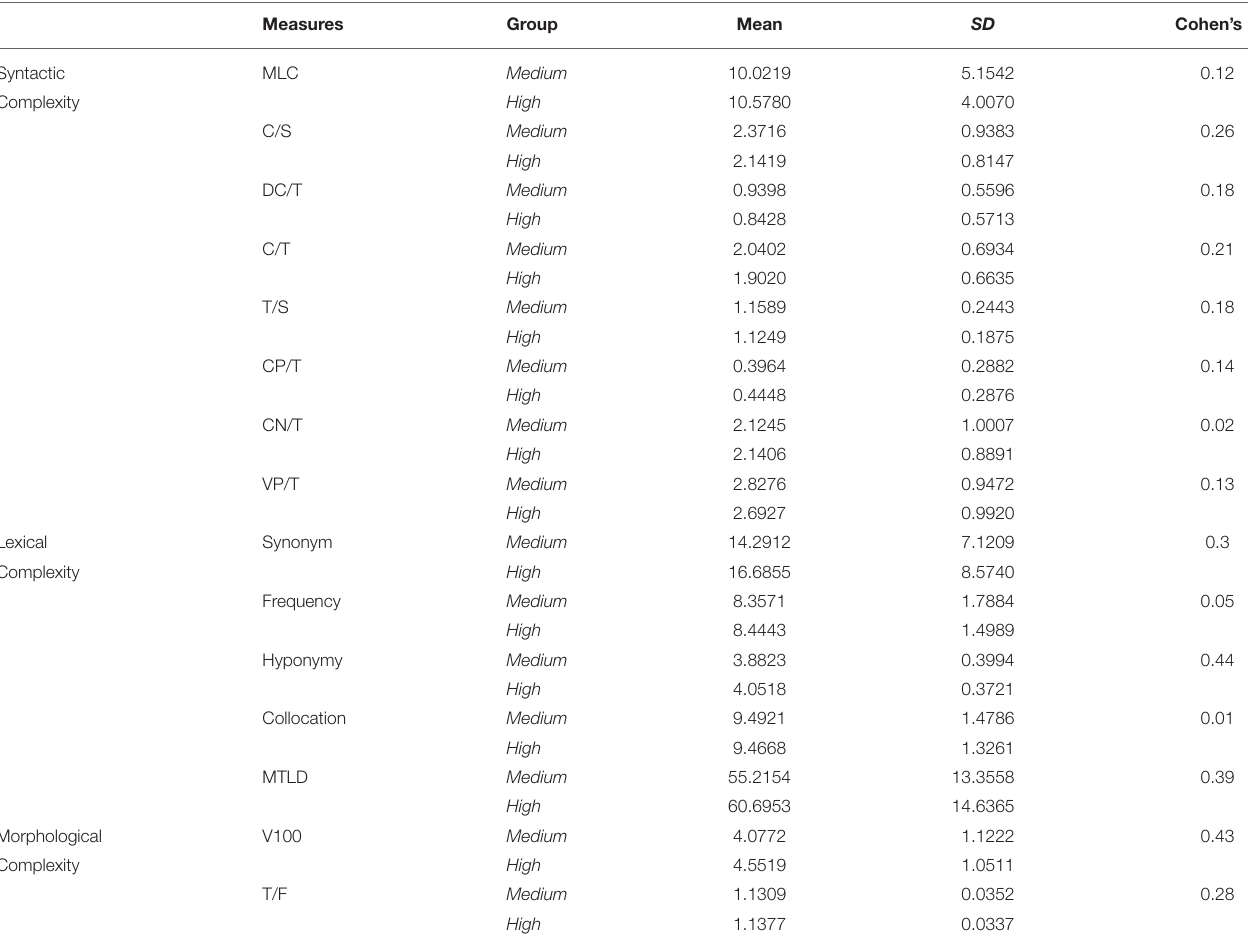
TABLE 6 | Statistics of complexity measures and effect